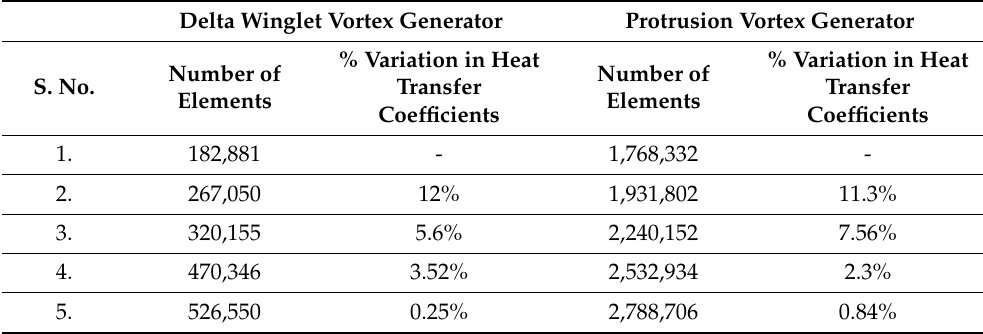
Table 4. Grid independence test for delta winglet vortex generator and protrusion vortex